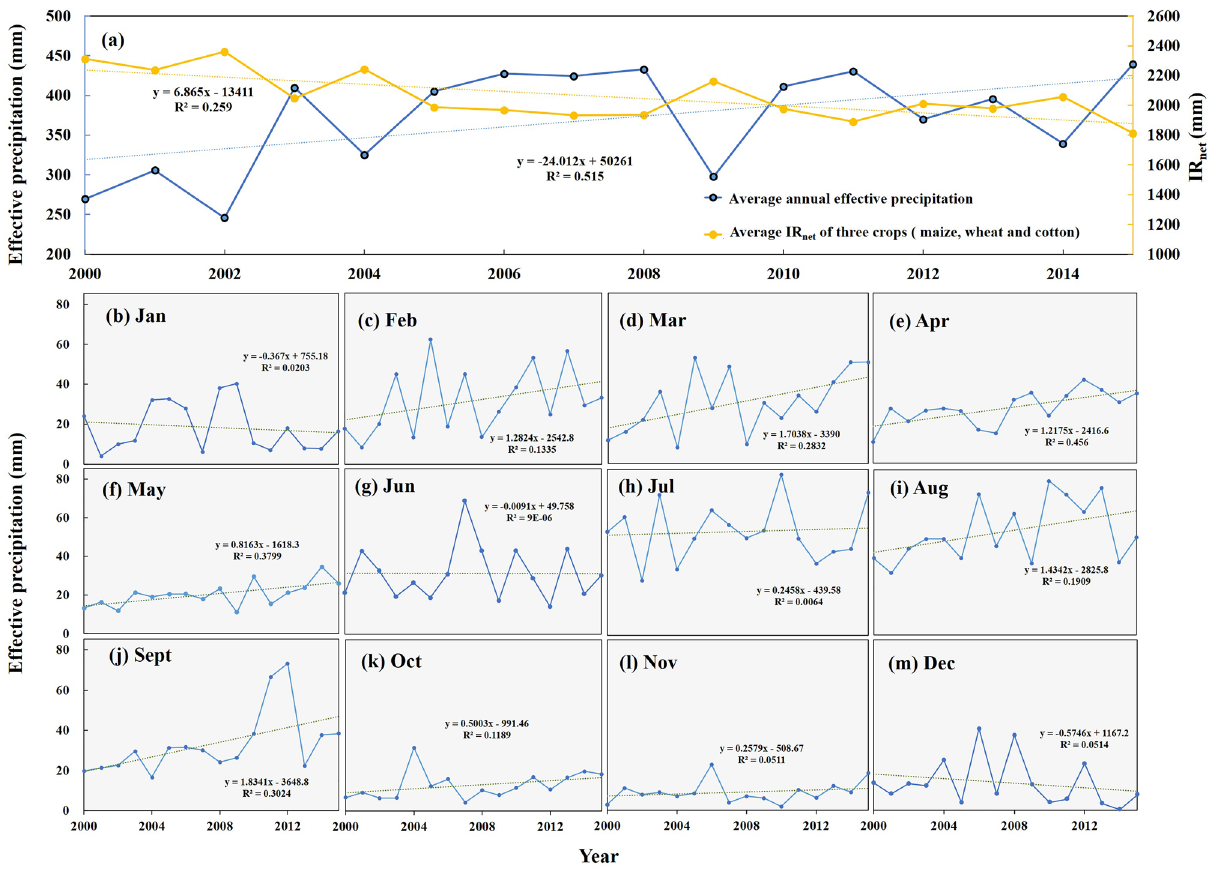
Figure 3. Inter-annual variation trends of the effective precipitation (P e ) and the average net irrigation water requirement (IR net ) for three crops (maize, wheat, and cotton) in the irrigated areas of the China–Pakistan Economic Corridor (CPEC) from 2000 to 2015.